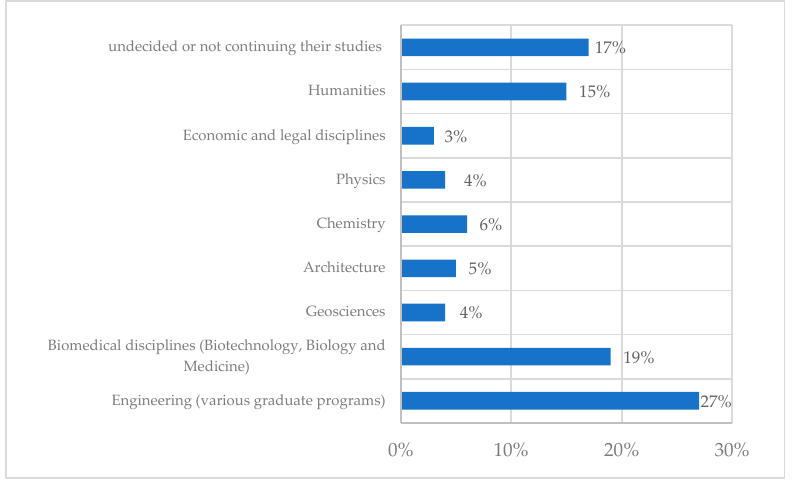
Figure 14. The choices after high school graduation of a sample of students who participated in the PLS–PNG project.